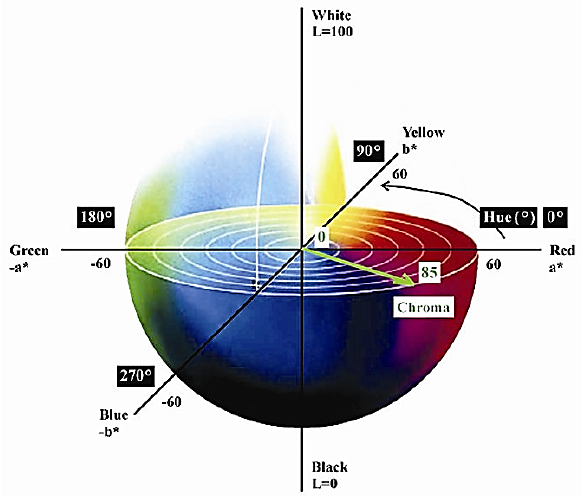
Figure 2: The color expressed in the picture consists of color coordi- nates [16] .